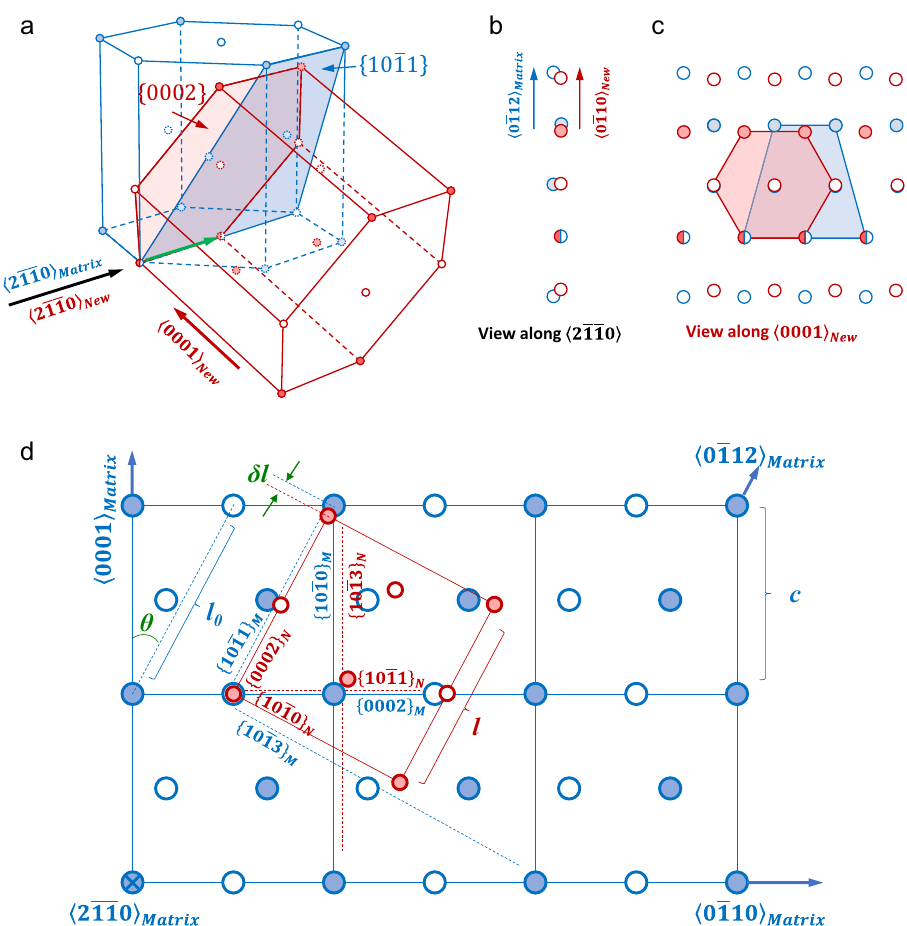
-- Fig. 6 Comparison between the structure of f 10 11 g and {0002} plane in Mg. a A matrix (blue) and a new HCP unit cell (red) with a 62 (cid:3) h 2 (cid:1) 1 (cid:1) 10 i misorientation. Atoms on different f 01 (cid:1) 10 g layers are represented by solid and open circles. The two planes joining at the interface, i.e., f 10 (cid:1) 11 g Matrix and f 0002 g New , are highlighted. The green arrow denotes the h 2 (cid:1) 1 (cid:1) 10 i shared by the two HCP unit cells. b , c The projection views of the overlapped f 10 (cid:1) 11 g Matrix and f 0002 g New . d A new HCP unit cell (in red) is delineated inside the matrix. The two lattices satisfy f 10 (cid:1) 11 g Matrix k f 0002 g New , f 0002 g Matrix k f 10 (cid:1) 11 g New , f 10 (cid:1) 10 g Matrix k f 10 (cid:1) 13 g New , and f 10 (cid:1) 13 g Matrix k f 10 (cid:1) 10 g New , with a zone axis of h 2 (cid:1) 1 (cid:1) 10 i .